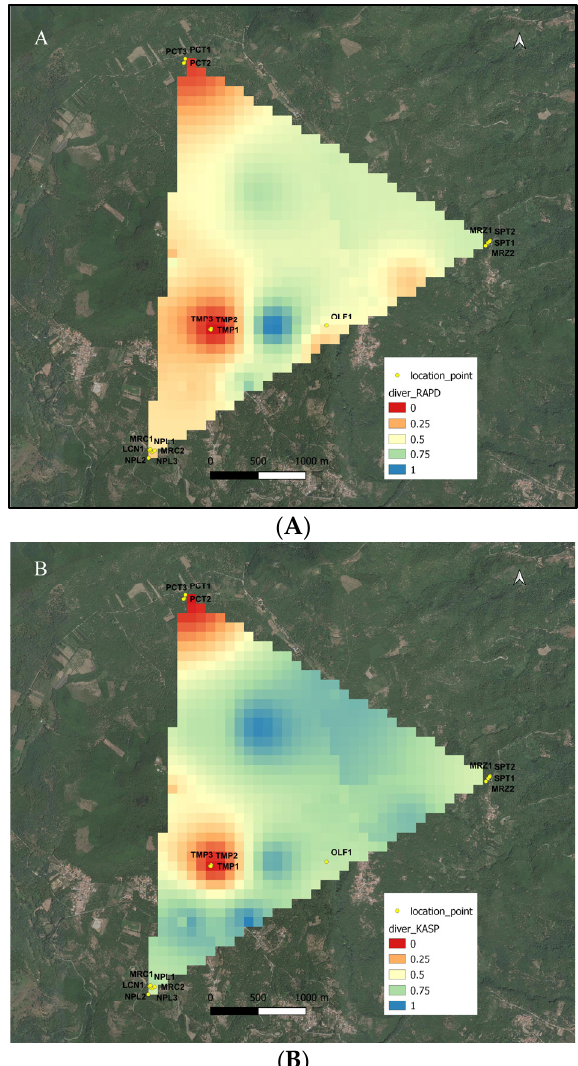
Figure 3. Distribution of the genetic distances based on RAPD ( A ) and KASP ( B ) molecular markers in the geographic space of the study area.